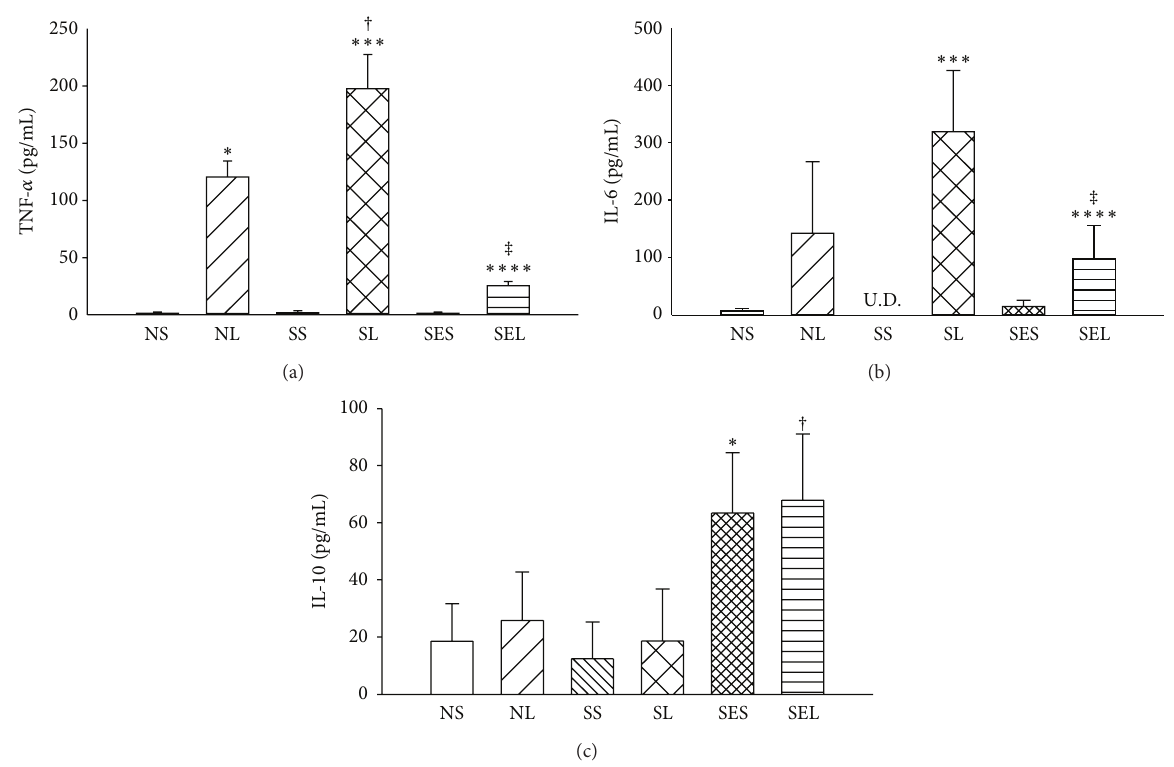
Figure 4: Levels of TNF- 𝛼 , IL-6, and IL-10 in lavage fluid at 240min after saline or LPS administration. NS: nondiabetic rats injected with saline; NL: nondiabetic rats injected with LPS; SS: STZ-induced diabetic rats injected with saline; SL: STZ-induced diabetic rats injected with LPS; SES: STZ-induced diabetic rats with exercise injected with saline; SEL: STZ-induced diabetic rats with exercise injected with LPS. Data are expressed as the mean ± SEM of eight rats per group. ∗ 𝑃 < 0.05 , compared with the NS group; † 𝑃 < 0.05 , compared with the NL group; ∗∗∗ 𝑃 < 0.05 , compared with the SS group; ‡ 𝑃 < 0.05 , compared with the SL group; ∗∗∗ 𝑃 < 0.05 , compared with the SES group (one-way ANOVA).